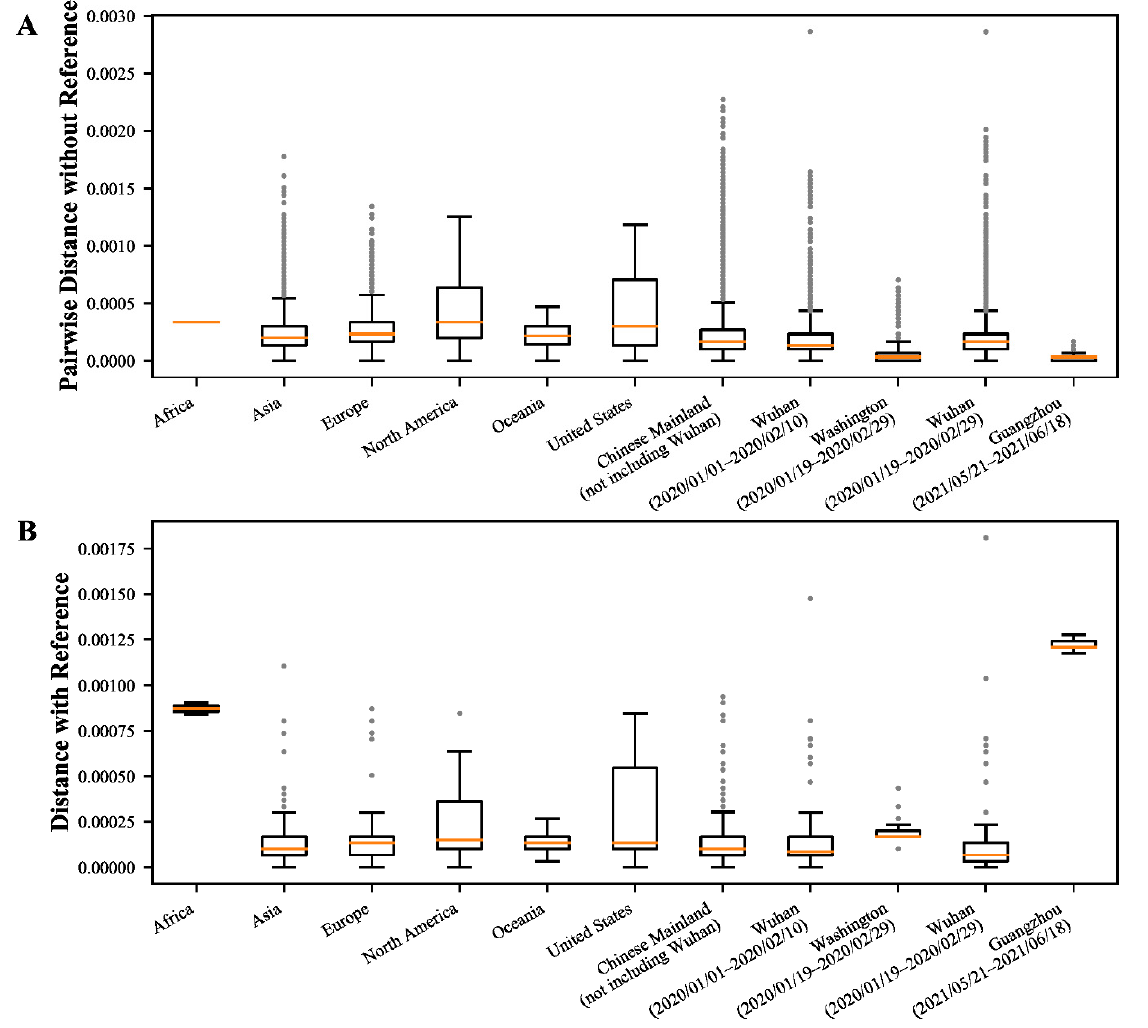
Figure 6. The evolutionary divergence among global early genome sequences. The box extends from the first quartile (Q1) to the third quartile (Q3) of the data, with a line at the median (salmon color). The whiskers extend from the box by 1.5 × the interquartile range (IQR). Flier points (silver color) are those past the end of the whiskers. ( A ) The pairwise distance between early genome sequences. ( B ) The pairwise distance between early genome sequences and the reference sequence